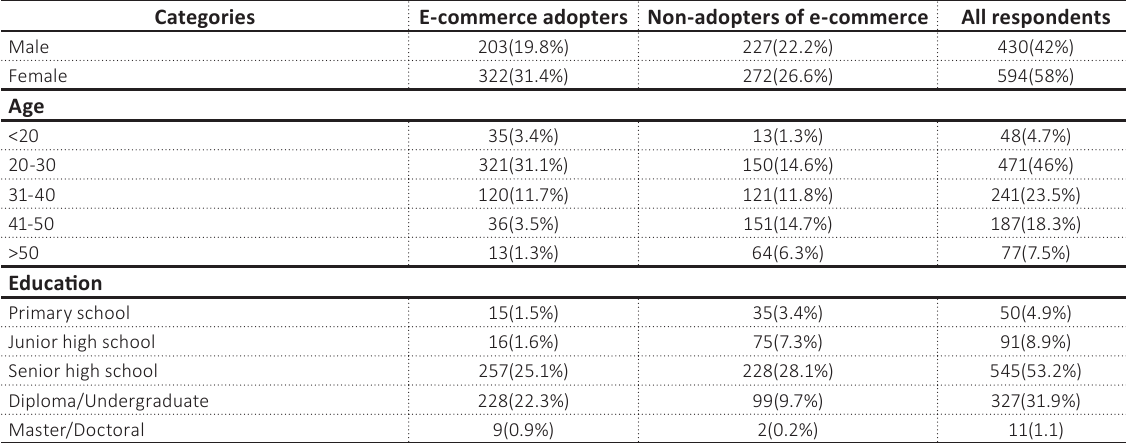
Table 1. Profile of respondents (N = 1024)